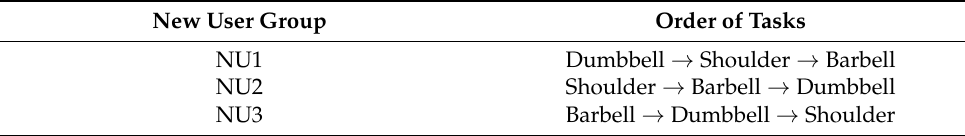
Table 8. Order of exercising tasks.